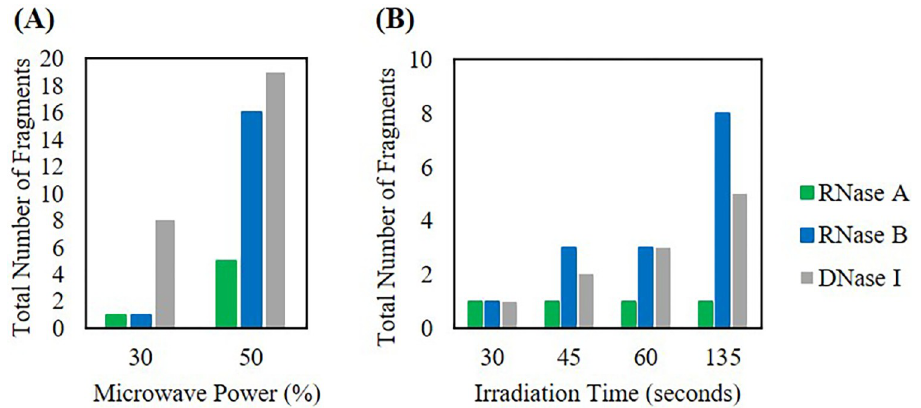
Fig 3. Total number of protein fragments for nucleases microwave irradiated with Lyse-It in DI water analyzed using the 2100 Bioanalyzer. Increasing the microwave irradiation power with Lyse-It (A) and Lyse-It irradiation time (B) . As microwave power or irradiation time increases, the number of nuclease fragments also increases.